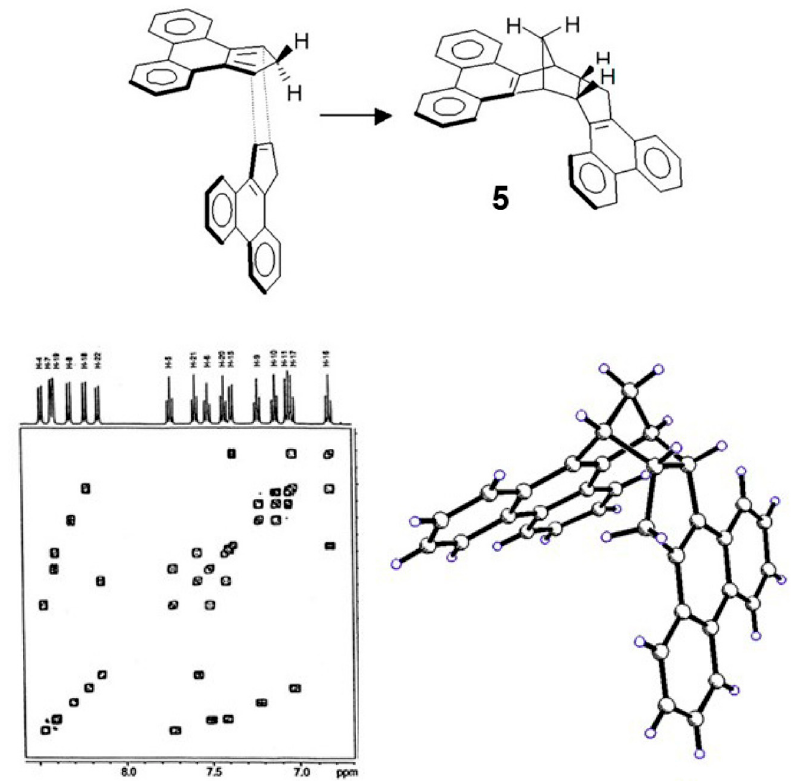
Figure 5. 500 MHz 1 H- 1 H COSY NMR spectrum in the aromatic region, and molecular structure, of the Diels-Alder dimer formed by reaction of cyclopenta[ l ]phenanthrene with its own isoindene [23]. Figure 5 is reprinted with permission of the American Chemical